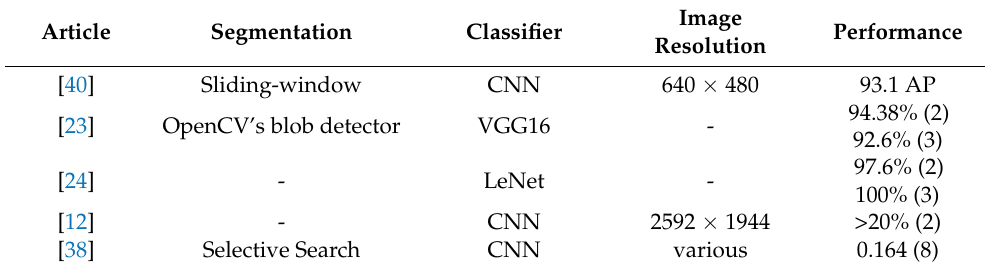
Table 2. C. pomonella counting methods. Empty cell means that the information is not